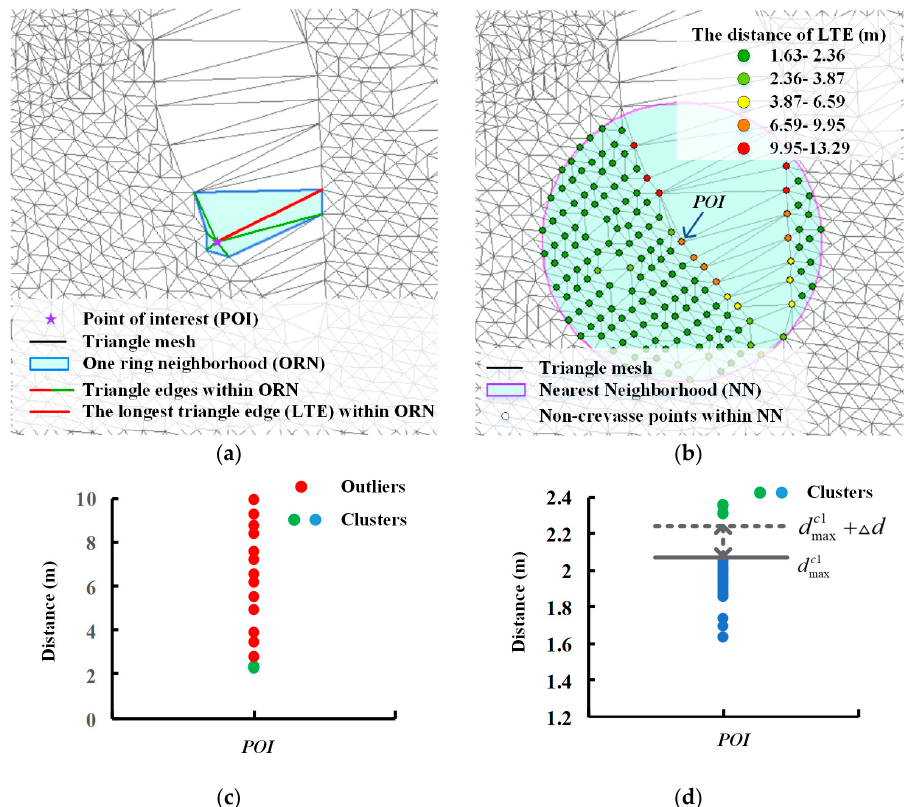
Figure 5. Illustration of the process of calculating the adaptive distance threshold using the DBSCAN algorithm. ( a ) Obtaining the longest triangle edge ( LTE ) within the one ring neighborhood ( ORN ) for a point of interest ( POI ). ( b ) Spatial distribution of the distances of the LTEs within a local neighborhood. ( c ) Grouping the distances of the LTEs within a local neighborhood of the POI by DBSCAN . ( d ) Calculating the adaptive threshold based on the grouping result of ( c ).